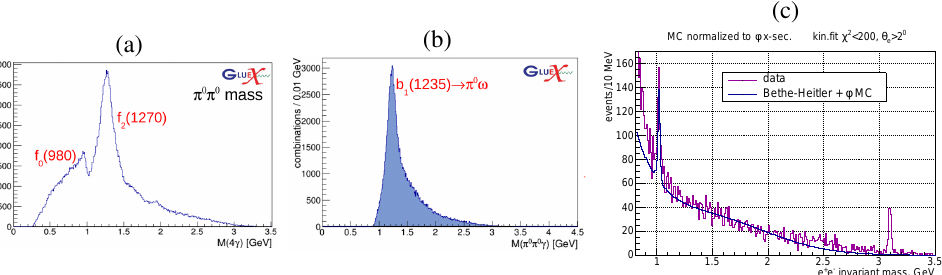
Figure 4. GlueX: signals observed in the 2016 data: (a) - f resonances in π 0 π 0 final state; (b) - b in ωπ 0 final state; (c) - e + e − final state in reaction γ p → e + e − p shows a signal from φ and a signal from J /ψ